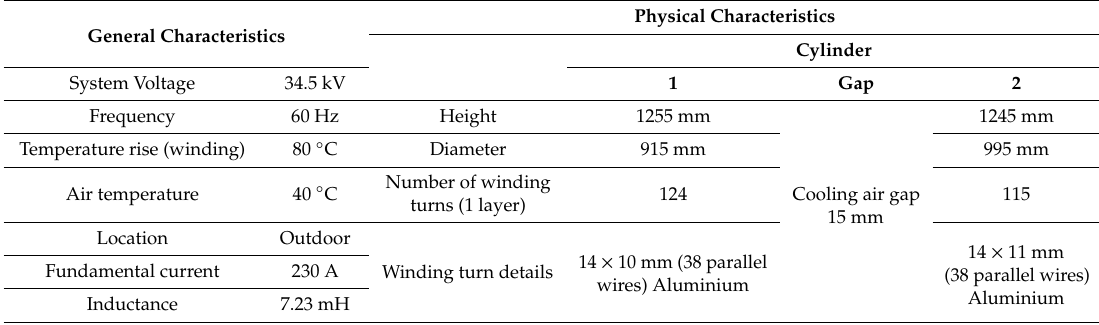
Table 5. Characteristics of dry-type air-core reactor in filter